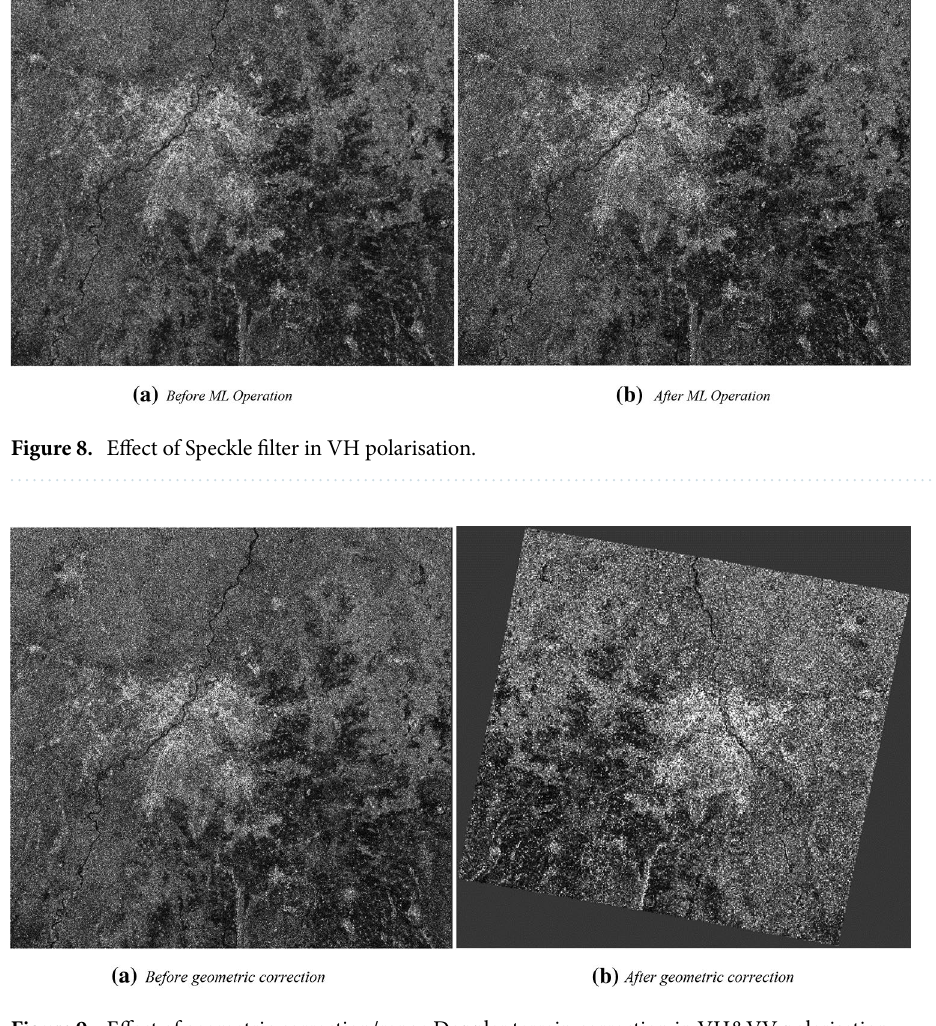
Figure 9. Effect of geometric correction/range Doppler terrain correction in VH&VV